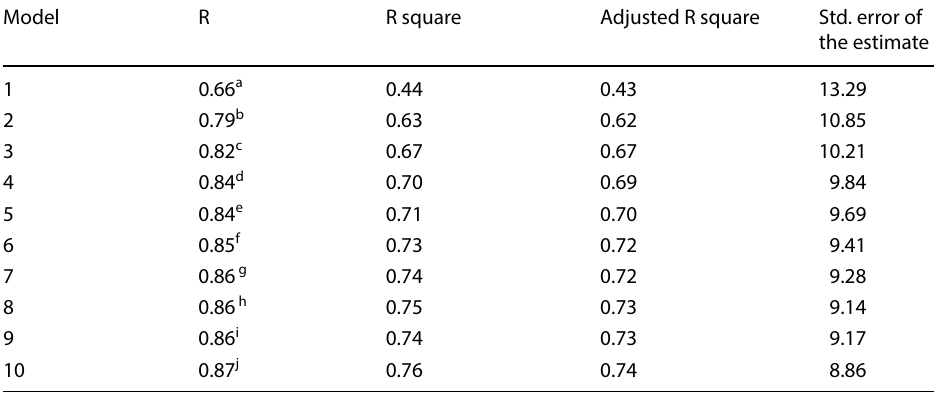
Table 5 Model Summary k of the Regression Based on Learners Learning Styles and their Reading